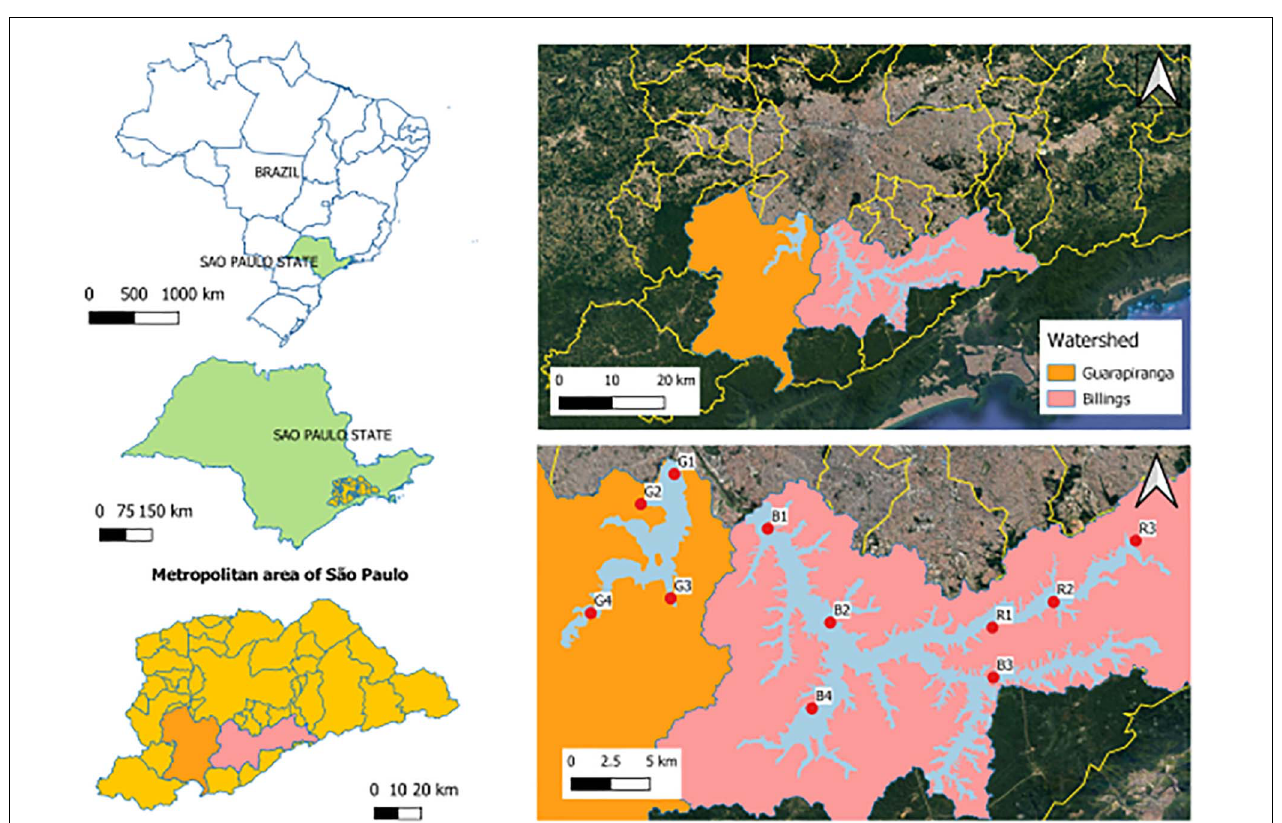
FIGURE 1 | Study area in São Paulo, Brazil. Highlight to the sampling stations in: Guarapiranga (G1–G4), Billings (B1–B4), and Rio Grande (R1–R3) reservoirs. Source: Google/Satellites.